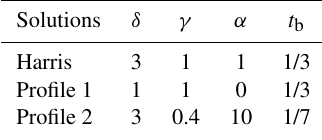
Table 1. Parameters used to obtain the profiles in Fig.